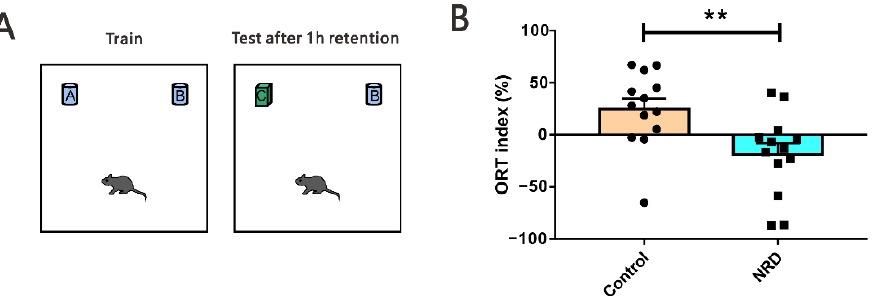
Figure 6. Defected cognition in object recognition memory in NRD mice. ( A ) Diagram of the novel object recognition test. ( B ) Performances of the control and NRD mice in the novel object recognition test. ** p < 0.01 as determined by unpaired Student’s t -test. Data are expressed as the means ± SEMs. n (control) = 13, n (NRD) = 13.